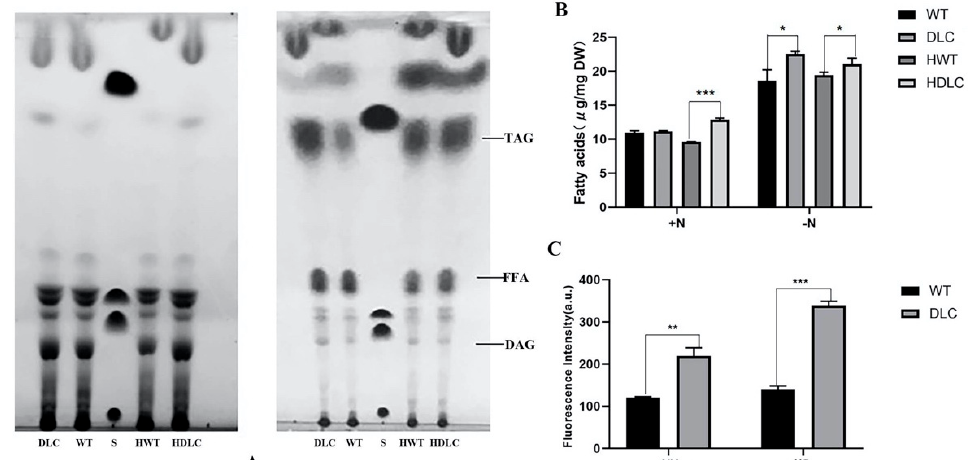
Figure 3. Analysis of the TAG in the DLC-4 and WT when they were treated with HS (HDLC and HWT) or without HS (DLC and WT). ( A ): Lipids were separated on a TLC plate and visualized with iodine. The lipids from strains in the nitrogen-replete and nitrogen-deprived conditions are shown separately in the left and right panels. ( B ): The TAG content of the DLC-4 and WT separated from TLC. +N: nitrogen-replete condition, − N: nitrogen-deprived condition. ( C ): The TAG content of DLC-4 and WT under nitrogen-deprived conditions when strains were treated with HS (HS) and without HS (NH). TAG was stained by BODIPY and measured by a microplate reader. Statistical significance (one-way ANOVA) is represented by asterisks (*, **, and *** indicate a difference at p ≤ 0.05, p ≤ 0.01, and p ≤ 0.005, respectively). Error bars depict SD. Total intracellular FA profiles were also analyzed by GC-MASS. The total FA of the DLC-4 and WT were 159.9 mg/g and 105.0 mg/g, and 133.9 mg/g and 102.6 mg/g dry cell weight (DCW) when strains were treated with and without HS, respectively. Thus, the titer and productivity of DLC-4 for lipids were 187.1 mg/L, and 32.2 mg/(L·d). Compared with WT, the total lipids of the DLC-4 increased by 52% and 31% with and without HS treatment, respectively (Figure 4A). However, the major lipids were still C16:0, C18:1, and C18:3 (Figure 4B,C). Moreover, the unsaturated FAs of the DLC-4 rose by 34% and 57% compared with WT when they were treated with HS and without HS, respectively. The content of FAs C16:1, C18:1, and C18:3 was increased significantly ( p < 0.01) in the DLC-4, with increases of 48%, 60%, and 33%, respectively, without HS. Similarly, the content of FAs C16:1, C16:4, C18:1, C18:2, and C18:3 increased significantly ( p < 0.01) in the DLC-4,